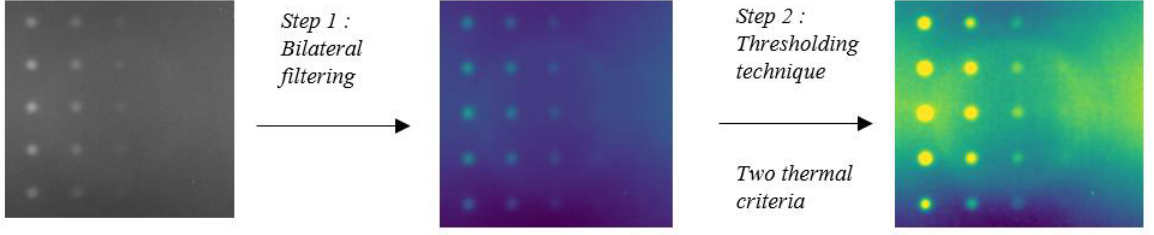
Figure 6. Scheme of preprocessing stage.